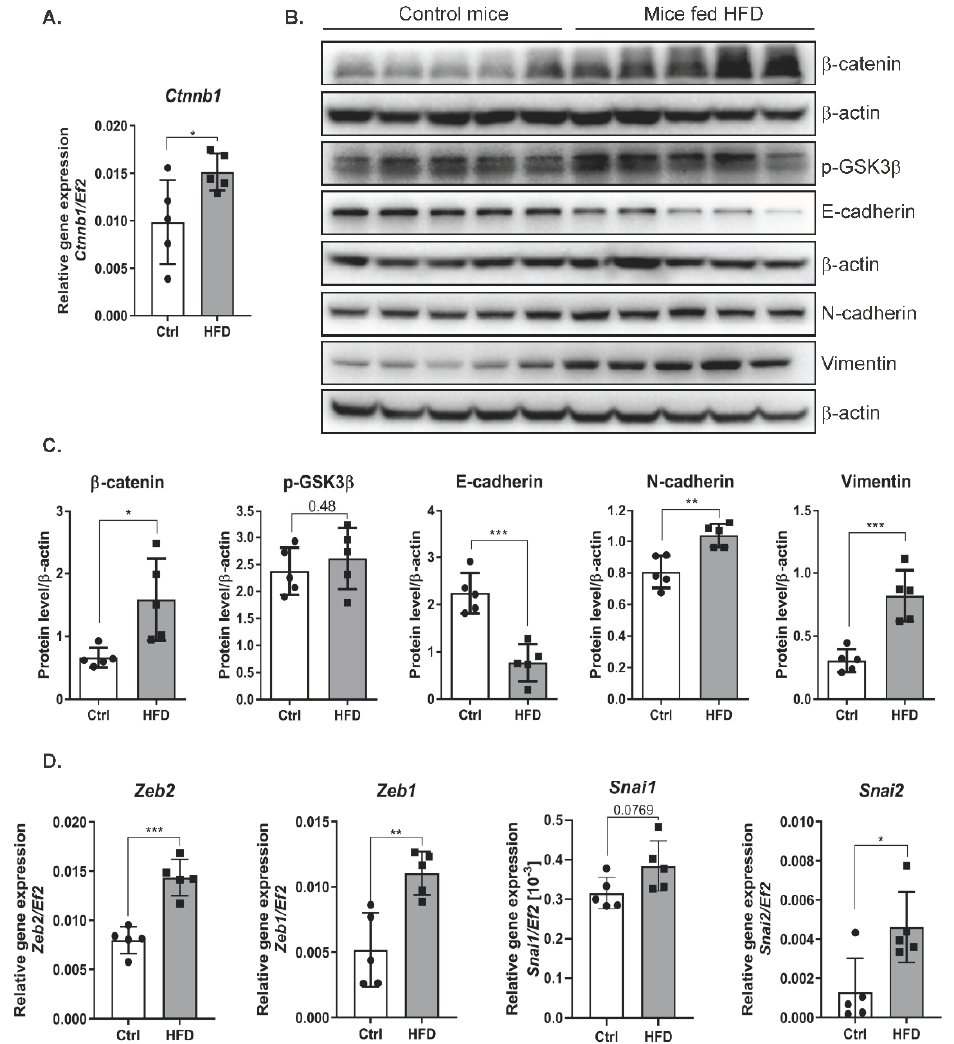
Figure 5. The effect of a high-fat diet on the level of epithelial and mesenchymal markers in liver cells of mice. ( A ) mRNA expression of β -catenin ( ctnnb1 ) in livers of the mice fed a control or a high-fat diet. Ctrl—mice on a control diet, HFD—mice fed a high-fat diet. The dots represent individual animals, n = 5 The EF2 gene was used as reference. ( B ) Analysis of epithelial and mesenchymal marker levels using the Western blot method. β -actin was used as the loading control. ( C ) Densitometric analysis of protein levels in mouse livers. Ctrl—mice on a control diet, HFD—mice fed a high-fat diet. The dots represent individual animals, n = 5. ( D ) The level of gene expression of transcription factors in mouse livers. Ctrl—mice on a control diet, HFD—mice fed a high-fat diet. The dots represent individual animals, n = 5. The EF2 gene was used as reference. The results are presented as the means ± SD, the Student’s t -test was used to determine the p -value, * p < 0.05; ** p < 0.01; *** p <